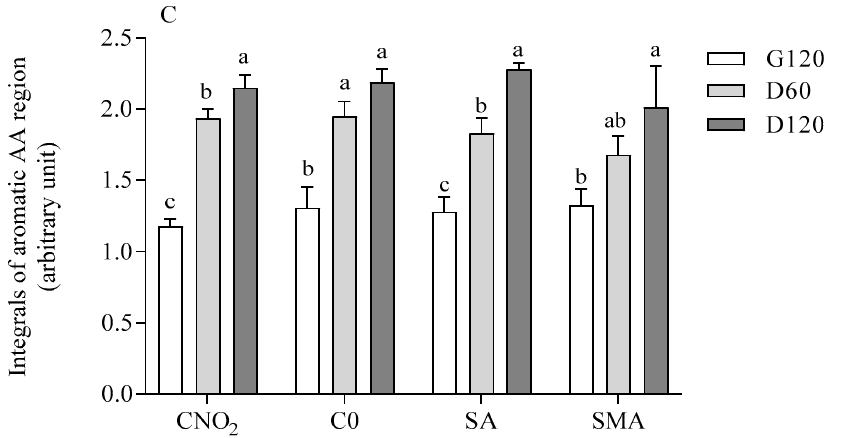
Figure 2. Integral area of aliphatic, α -proton, and aromatic amino acid regions at different digestion times in different salamis. Data are means ± SD of in vitro digestion of three independent samples analyzed in duplicate. Integrals of aliphatic ( A ), α -proton ( B ), and aromatic ( C ) amino acid regions are expressed as signal areas. Statistical analysis was by one-way ANOVA (always p < 0.05) with Tukey’s post-hoc test comparing the three digestion times in each salami formulation (different letters indicate significant differences). G120: end of gastric phase; D60: 60 min of duodenal phase; D120: end of duodenal phase; AA: amino acids; C-NO 2 : salami with sodium nitrite, potassium nitrate and with nitrate-reducing microbial starter cultures; C-0: salami containing neither nitrate-reducing microbial starter cultures nor additives (nitrite, polyphenols and ascorbate); SA: salami with nitrate-reducing microbial starter cultures and sodium ascorbate; SMA: salami with nitrate-reducing microbial starter cultures, sodium ascorbate and plant